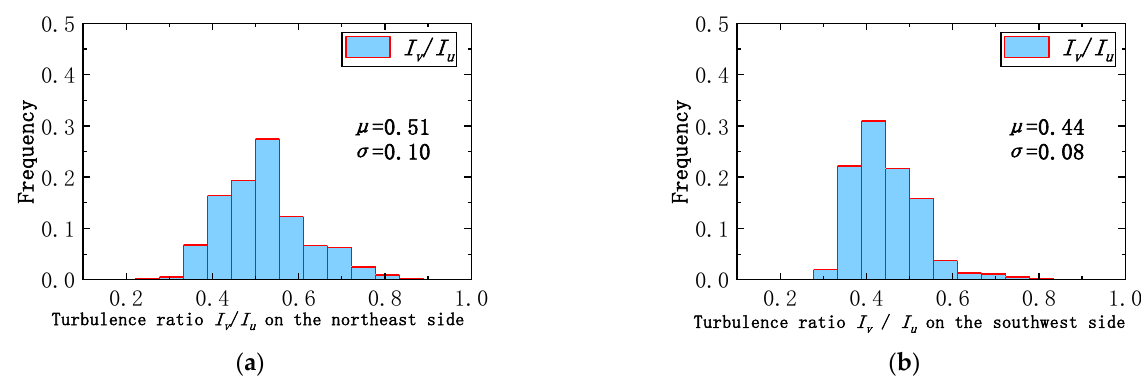
Figure 16. Frequency histogram of the ratio I v / I u of crosswind turbulence to downwind turbulence: ( a ) I v / I u on the northeast side; ( b ) I v / I u on the southwest side.